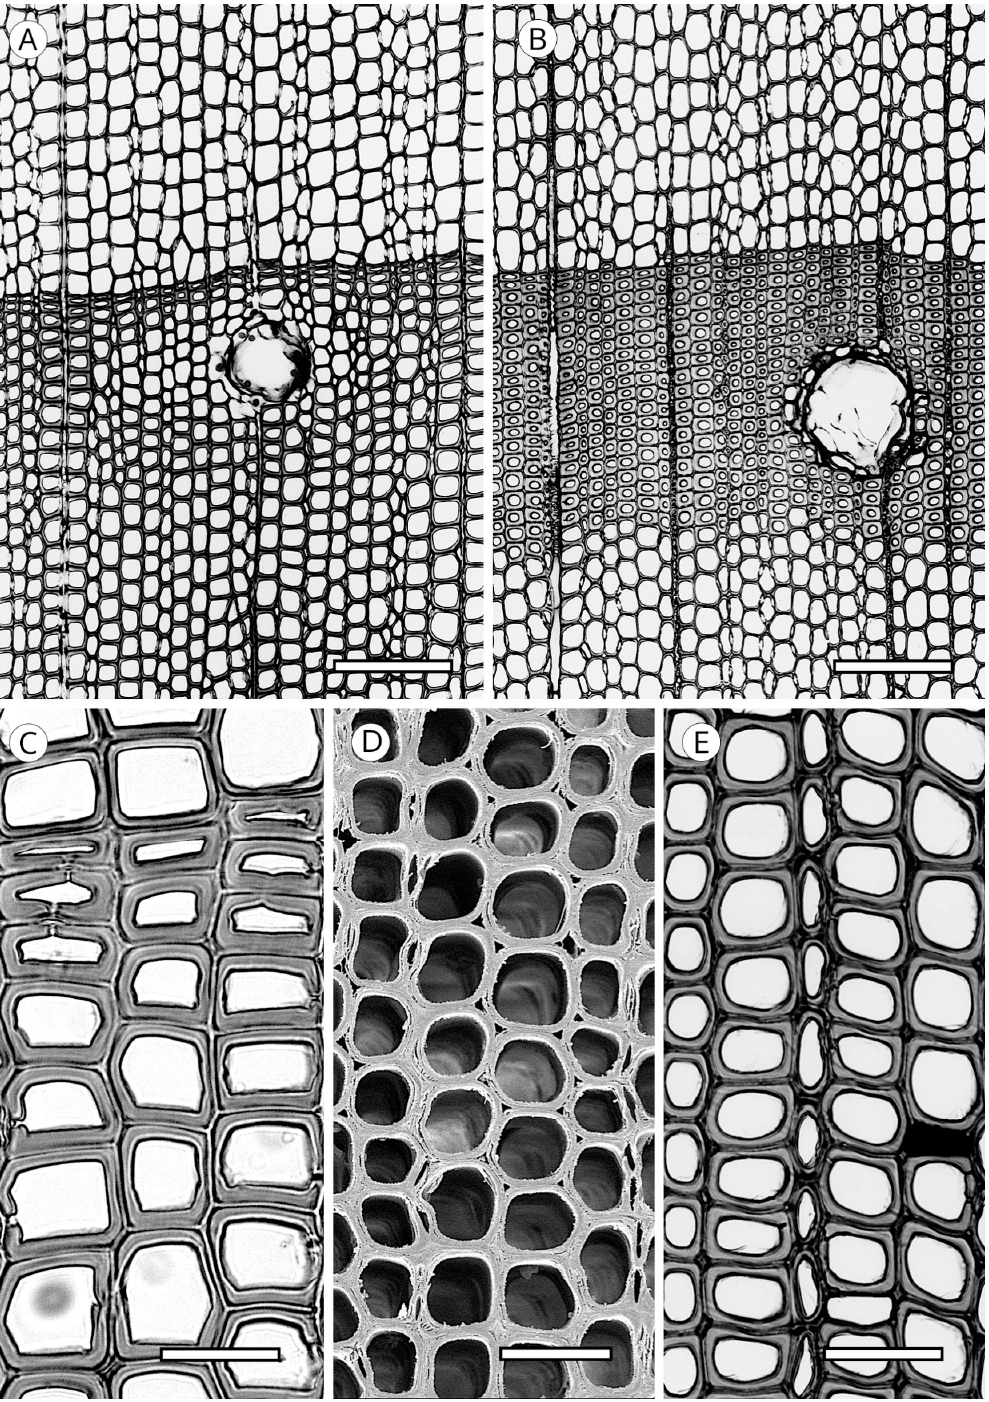
Figure 9. Axial tracheids. ( A ) Thin-walled in Pinus strobus L.; ( B ) Thick-walled in Pinus palustris Mill.; ( C ) Polygonal tracheids in Callitropsis nootkatensis (D.Don) Oerst. (Syn.— Xanthocyparis nootkatensis (D.Don) Farjon & Harder); ( D ) Circular tracheids in Callitris endlicheri (Parl.) F.M.Bailey (SEM); ( E ) Polygonal tracheids with circular lumen in Falcatifolium falciforme (Parl.) de Laub. Scale bars. ( A , B ) = 250 μ m; ( C – E ) = 50 μ m.